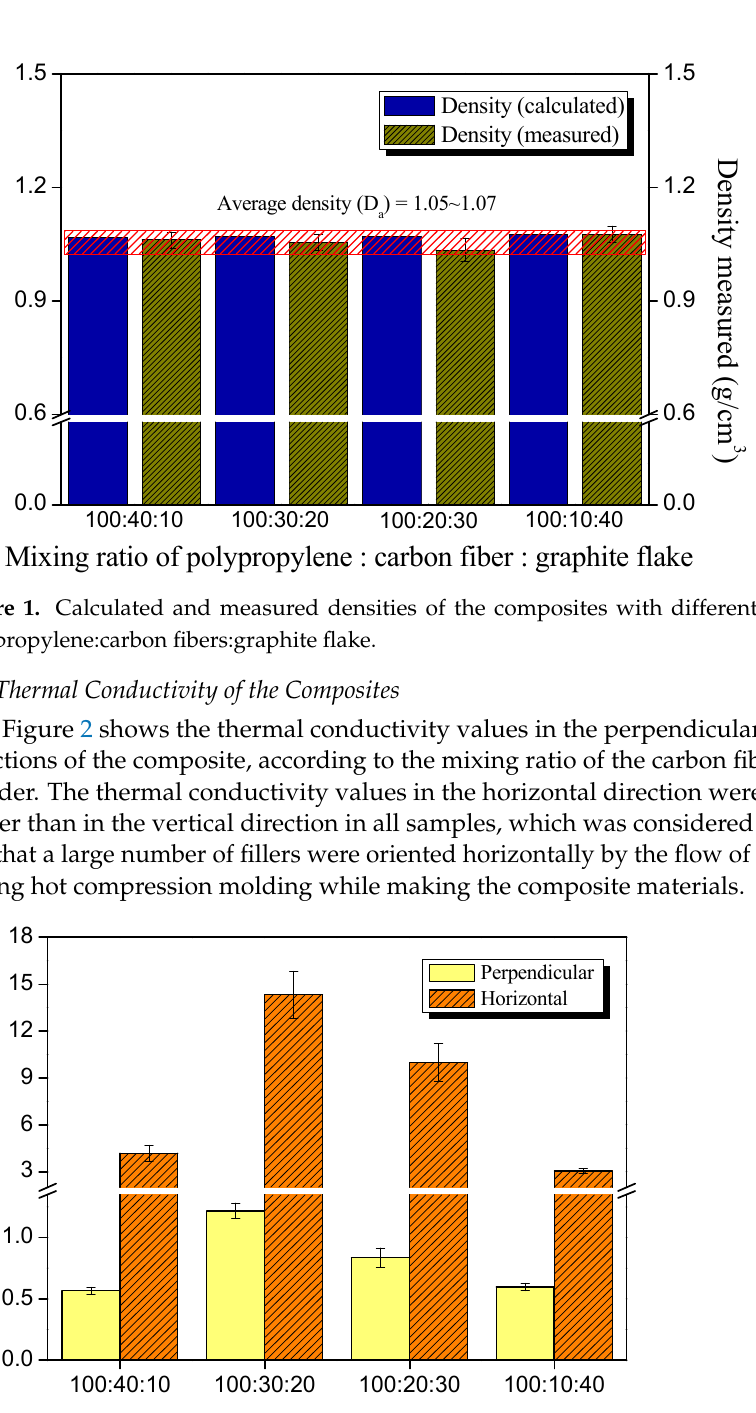
Figure 1. Calculated and measured densities of the composites with different mixing ratios of poly- propylene:carbon fibers:graphite flake.